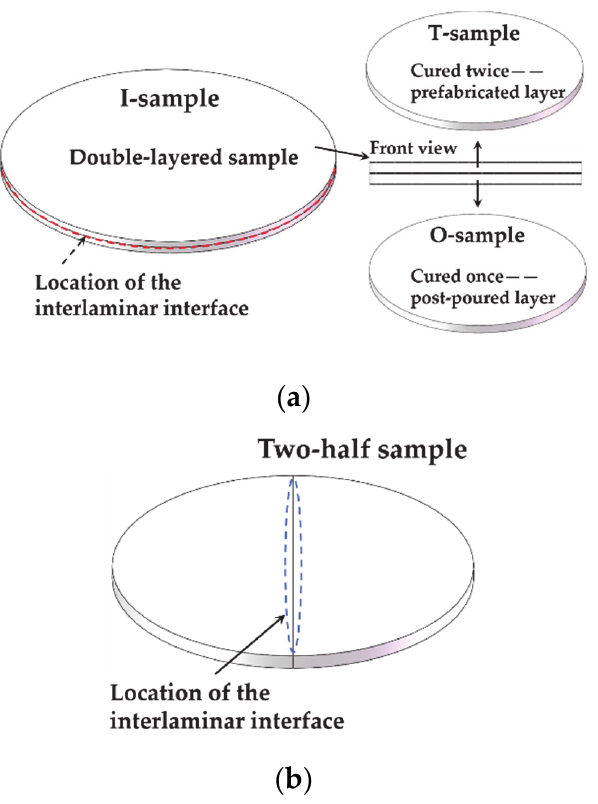
Figure 5. Schematic diagrams of interface position in the interface samples: ( a ) different types of samples; ( b ) two-half sample. Table 2. Characteristics of the different types of samples.